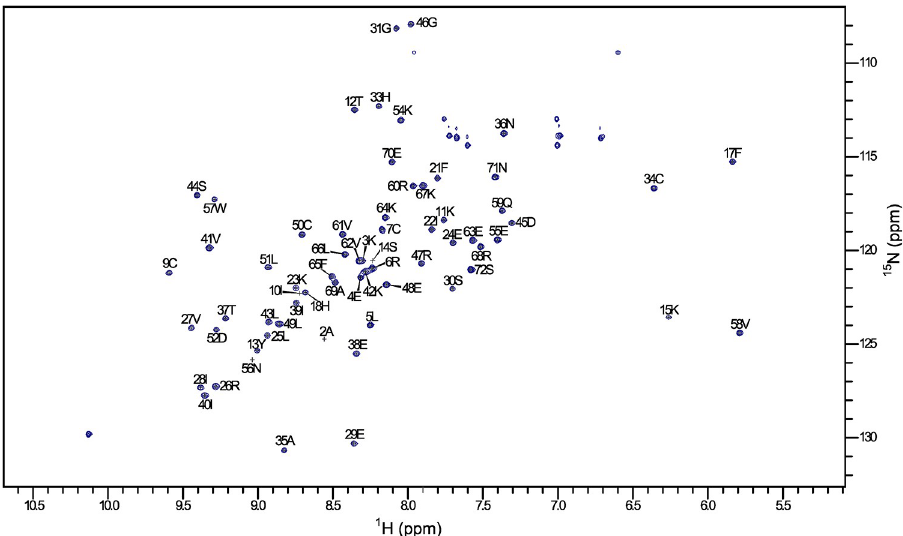
Fig 3. 1 H, 15 N-HSQC spectrum of [ U - 15 N]-labelled CXCL8 recorded at 298K. The spectrum is indicative of a folded sample with well dispersed and resolved peaks. 83 peaks are observed consistent with the expected number of backbone and side chain resonances. 67 peaks were assigned to the backbone yielding 99% sequence coverage, excluding the 4 proline residues. The N-terminal serine residue could not be assigned.